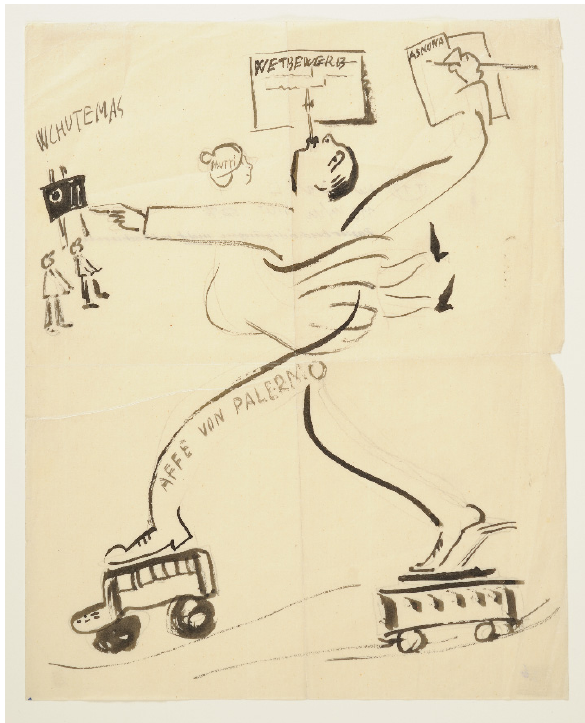
Figure 34. El Lissitzky, Drawing in a letter to Sophie Küppers, 1924. Van Abbemuseum. Photo: Peter Cox.